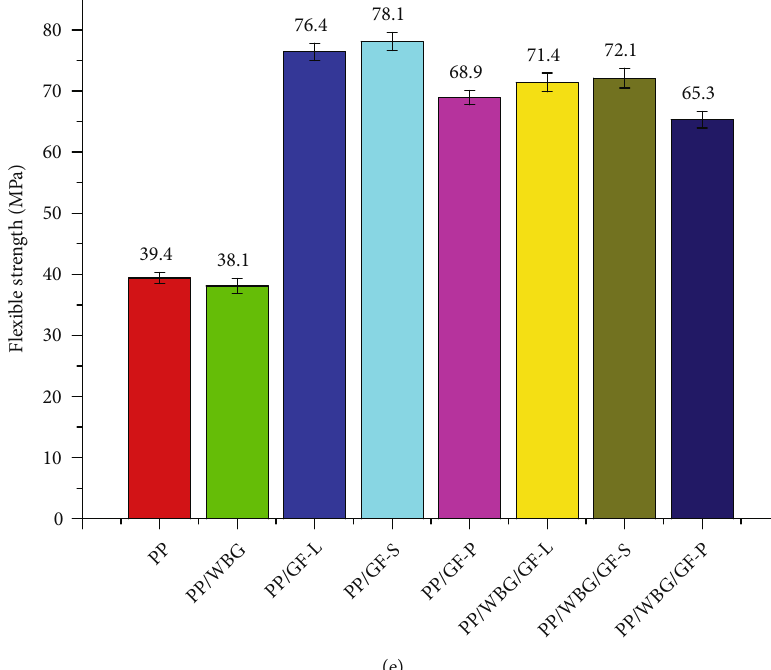
Figure 5: The tensile strength (a), fl exural modulus (b), impact strength (c), tensile modulus (d), and fl exible strength (e) of